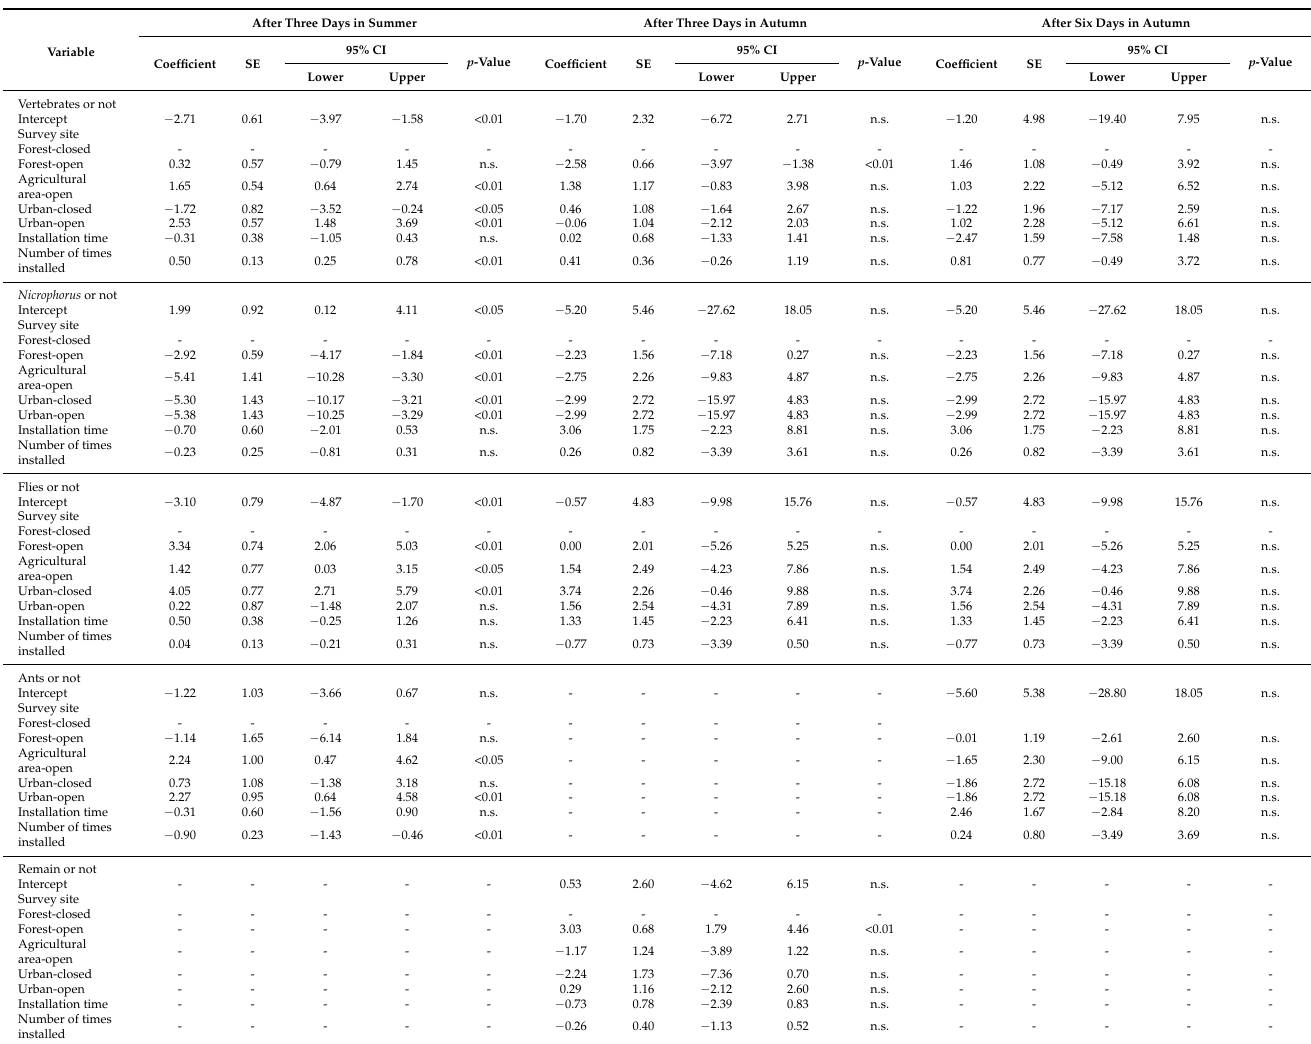
Table 1. Parameter estimates of Firth’s bias-reduced logistic regression for the pattern of the disap- pearance of the carcasses placed at each survey site in each